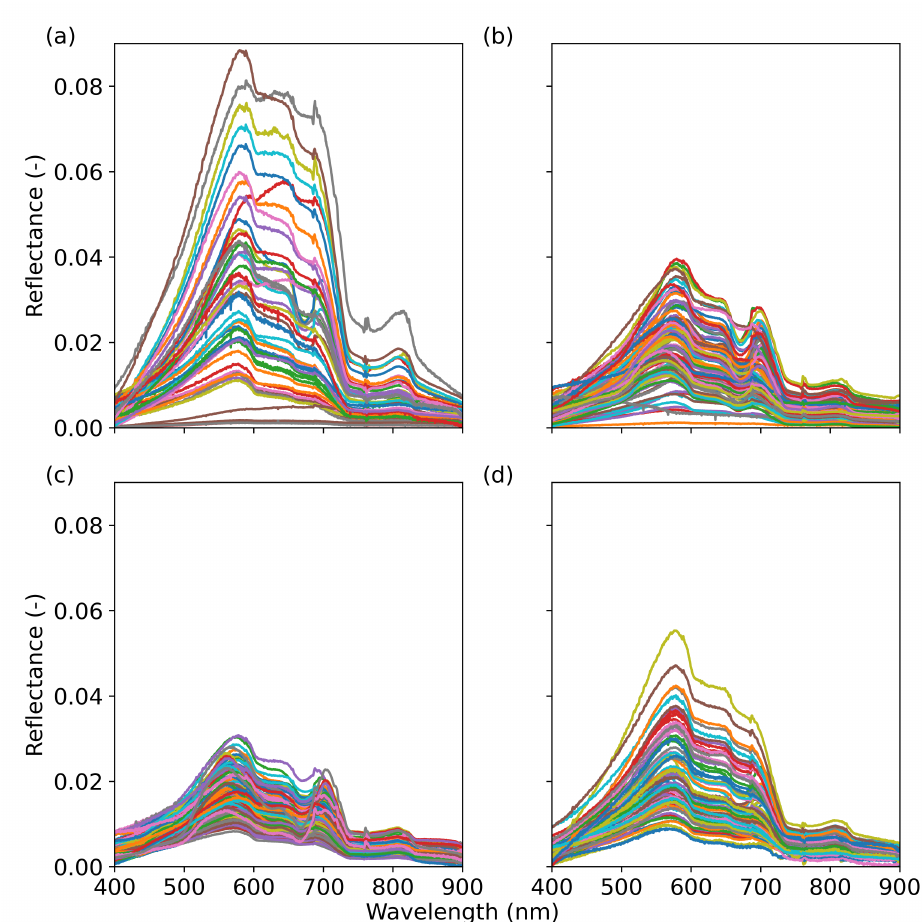
Figure 3. Reflectance spectra measured at Blankaart and averaged per day (to maximize visibility, each day has a different color) for the winter (December, January and February) ( a ), spring (March, April and May) ( b ), summer (June, July and August) ( c ), and autumn (September, October and November) ( d ).